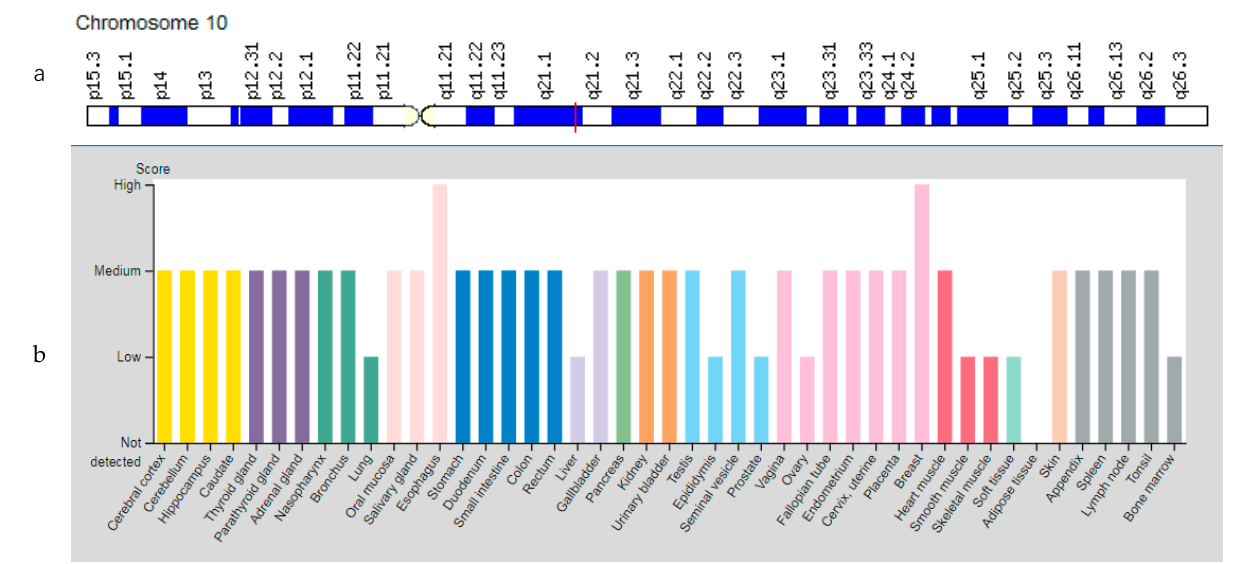
Figure 7. Location of the TFAM gene ( a ) and tissue expression of the transcription factor A, mito- 523 chondrial ( b ). 524